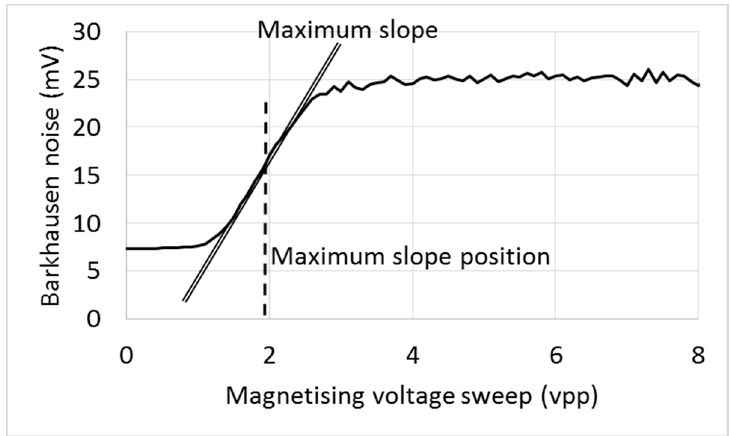
Figure 1. Voltage sweep, and maximum slope and its position.